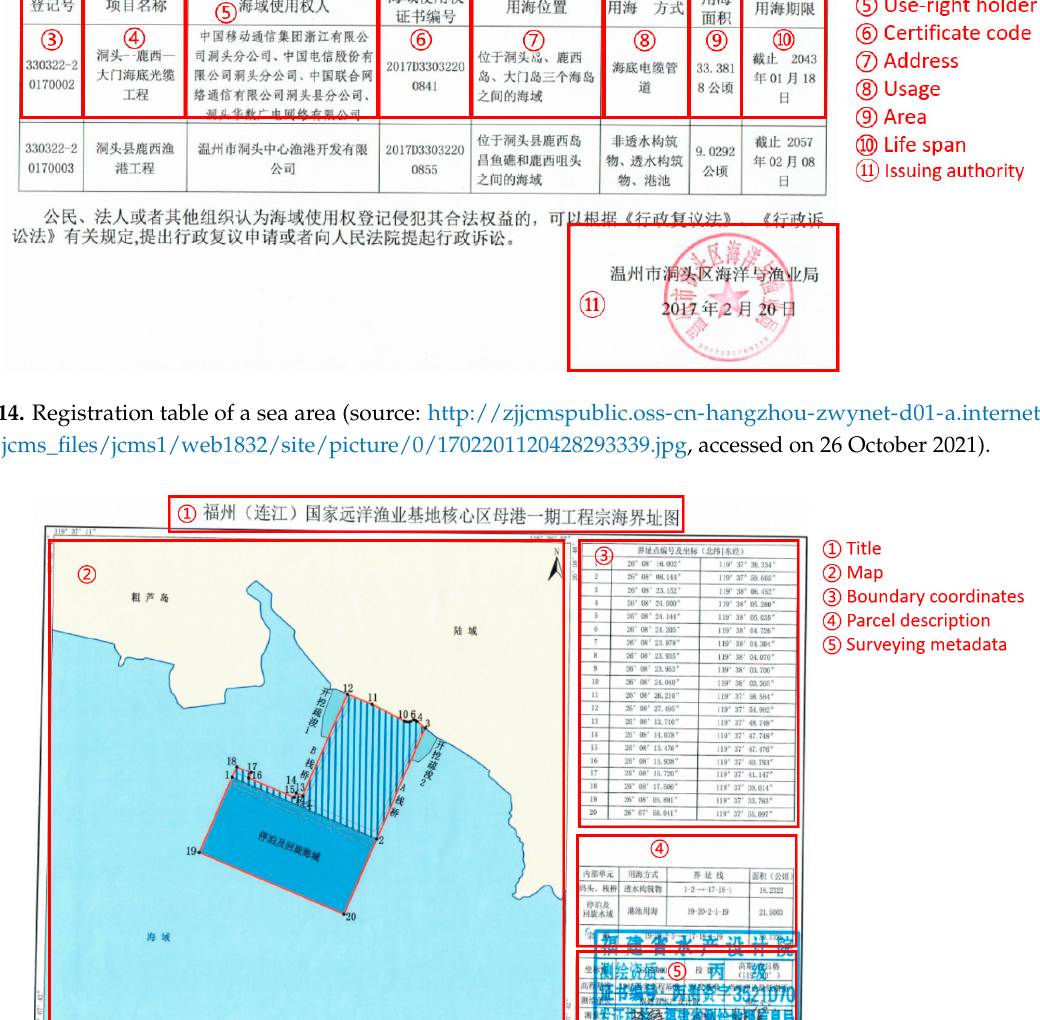
Land 2021 , 10 , x FOR PEER REVIEW 14 of 22